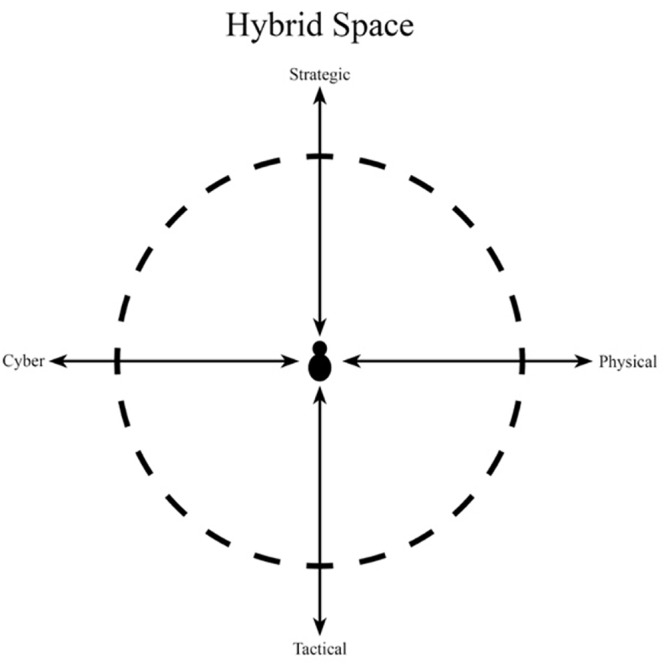
The Hybrid Space conceptual framework (Jøsok et al., 2016).